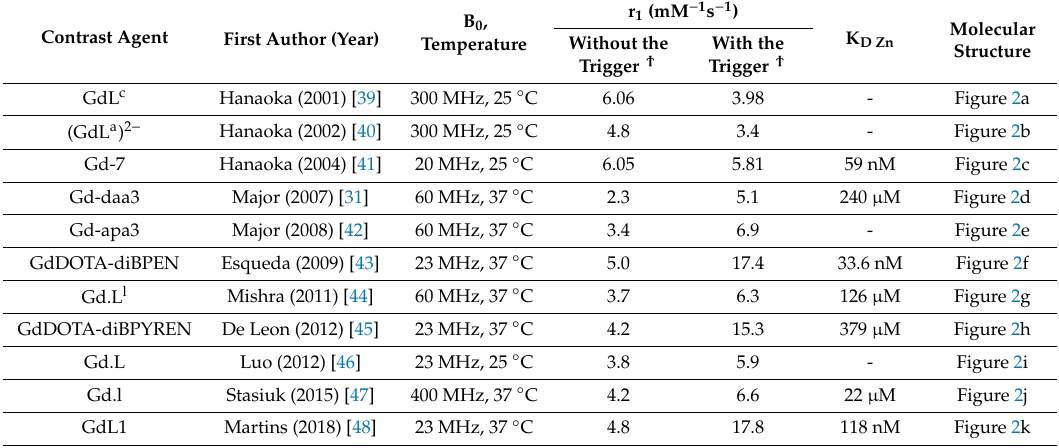
Zn 2 + with or without human serum albumin